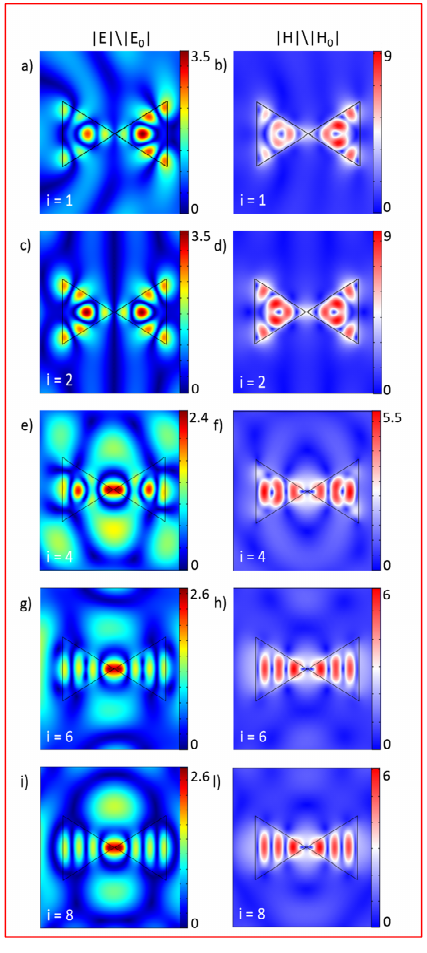
Figure 3. The electric ( a ), ( c ), ( e ), ( g ), ( i ) and magnetic ( b ), ( d ), ( f ), ( h ), ( l ) field enhancement when the number of pump plane waves i is equal to 1, 2, 4, 6 and 8, respectively, assuming the same total incident power. The optimized parameters of the plane waves are those reported in Figure